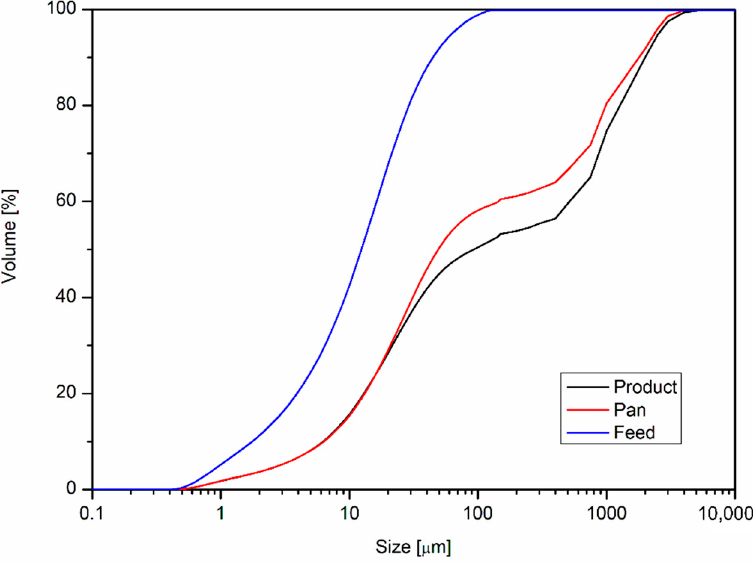
Figure 5. PSD for product, feed, and pan samples of the reference experiment.